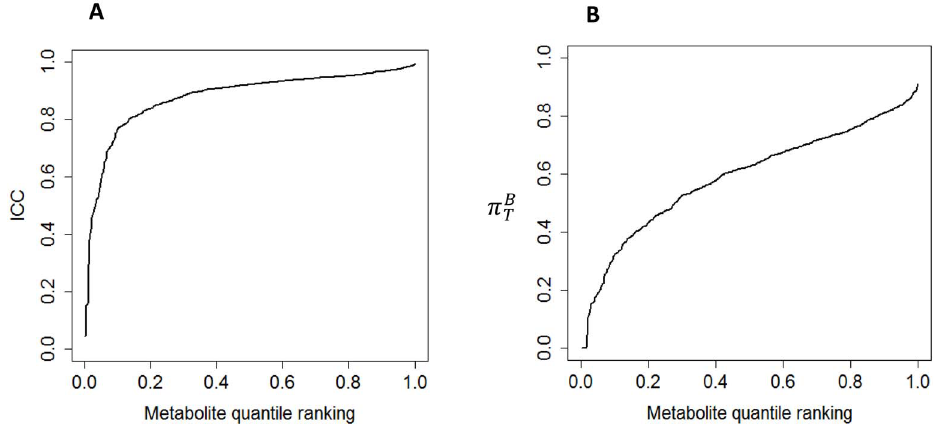
( B) of overnight urinary samples in the Navy Colon T is a measure of between-individual variance. The curves illustrate the ICC T : 0.62. T